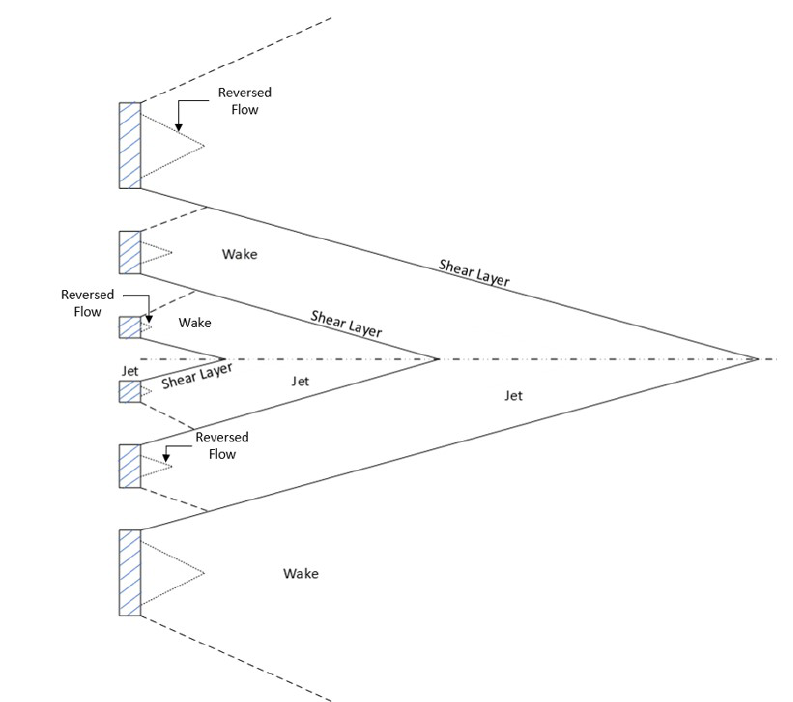
Figure 5. Schematic of the different flow regions of the mean flow behind a fractal square grid.